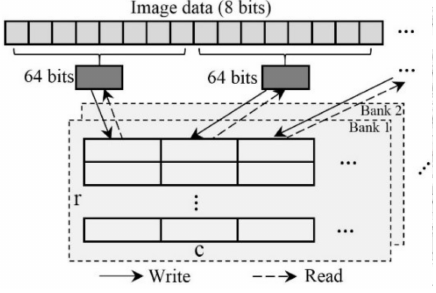
Figure 4. Writing/reading